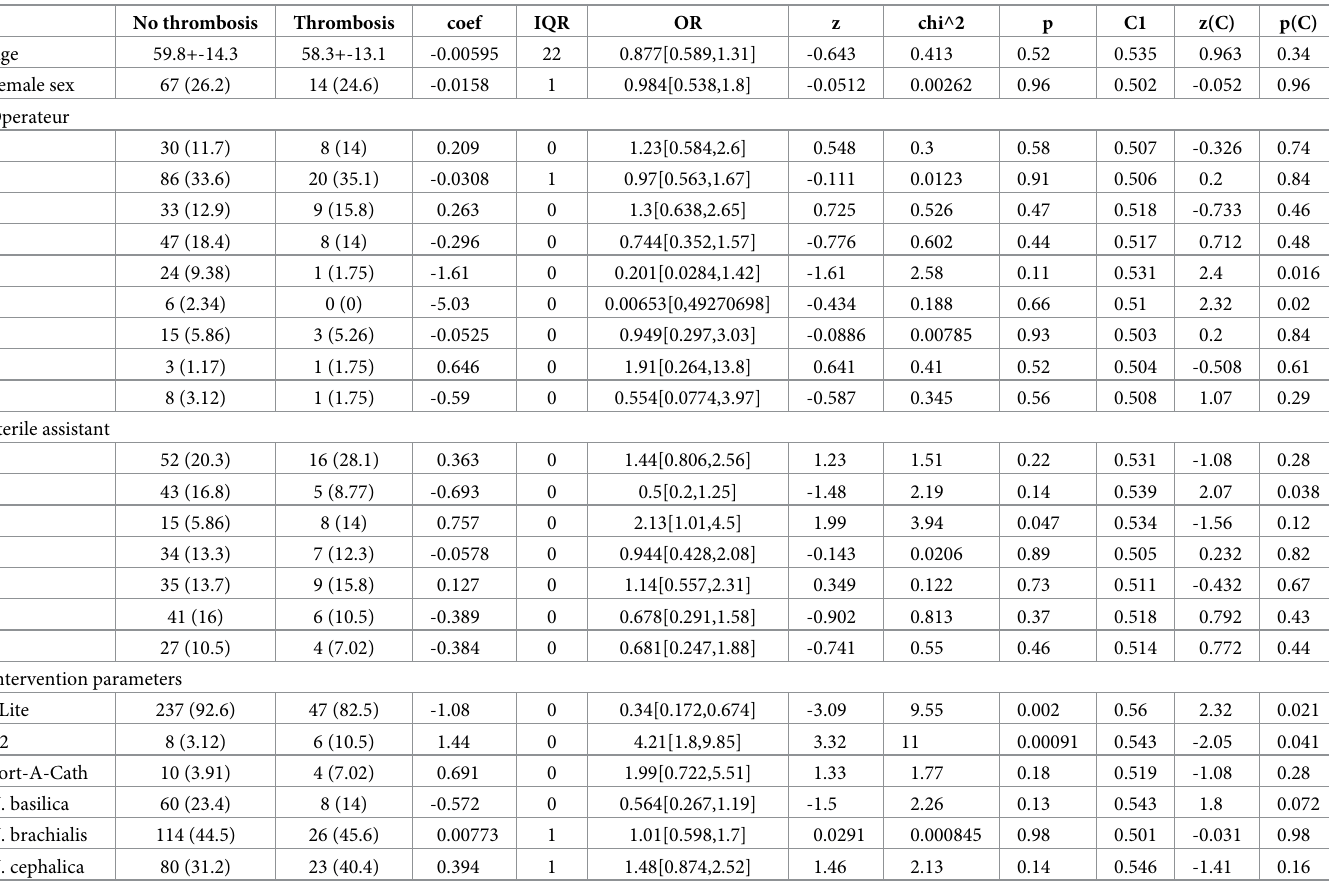
Table 3. Univariate analysis of the most relevant variables on thrombosis free